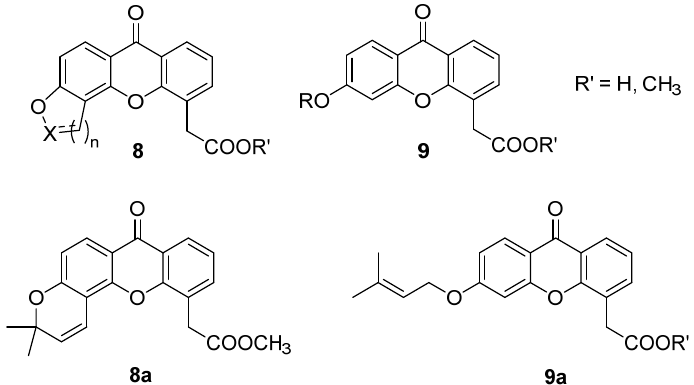
Figure 5. Cyclic DMXAA analogues and alkoxy derivatives.